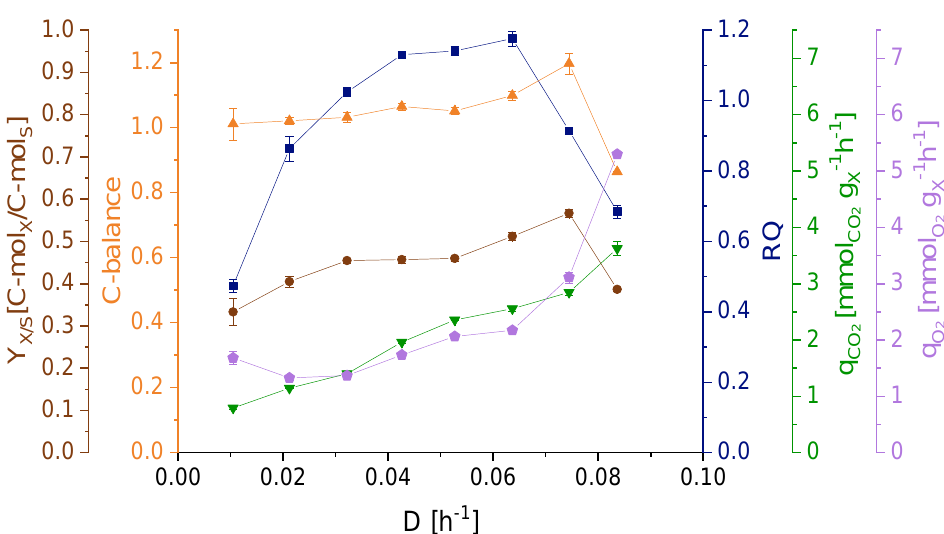
Figure 6. Biomass yield ( Y X / S ), C-balance, respiratory quotient (RQ), specific carbon dioxide production rate (q CO2 ) and specific oxygen consumption rate (q O2 ) at each dilution rate. Error bars indicate the difference between the various sampling points after reaching steady state in the continuous cultivation.